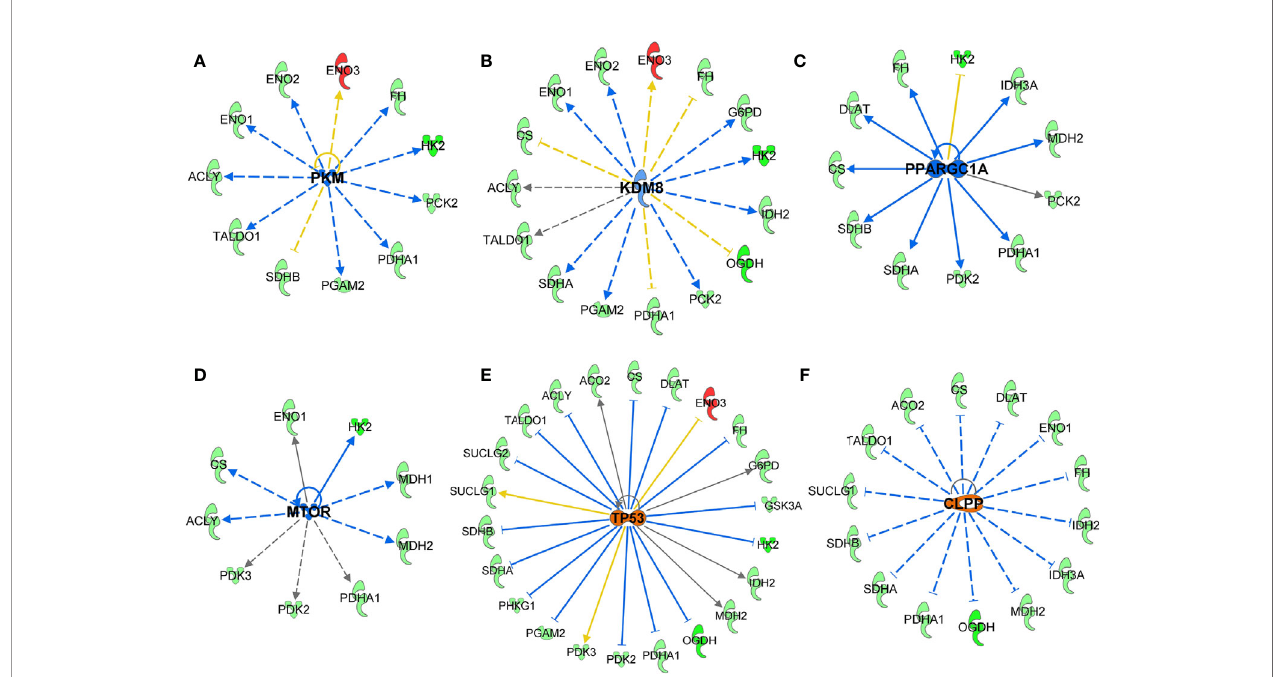
FIGURE 6 | Key upstream signaling pathways predicted in response to SIRT3 knockdown (shSIRT3- SK-MEL-2). Using IPA, upstream regulator analysis identi fi ed genes potentially involved in melanoma or cancer. These are (A) PKM, (B) KDM8, (C) PPARGC1A, (D) mTOR, (E) P53, and (F) CLPP signaling. Upstream regulations are denoted with blue (inhibition) (F) or orange (activation) color. The interaction lines are indicated as solid (robust interactions), dashed (signi fi cant but less frequent), blue (inhibition), orange (activation), yellow ( fi nding inconsistent), and gray